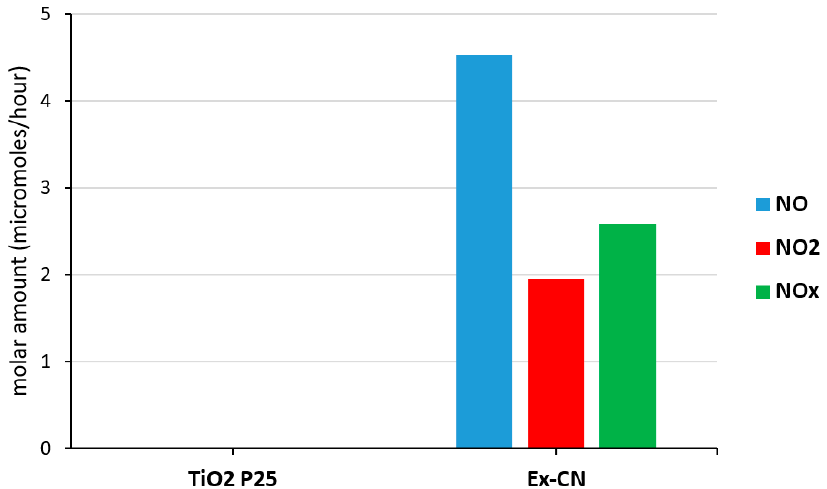
Figure 9. Amount of removed NO, NO x and formed NO 2 under VIS LED irradiation during 1 h of experiment.